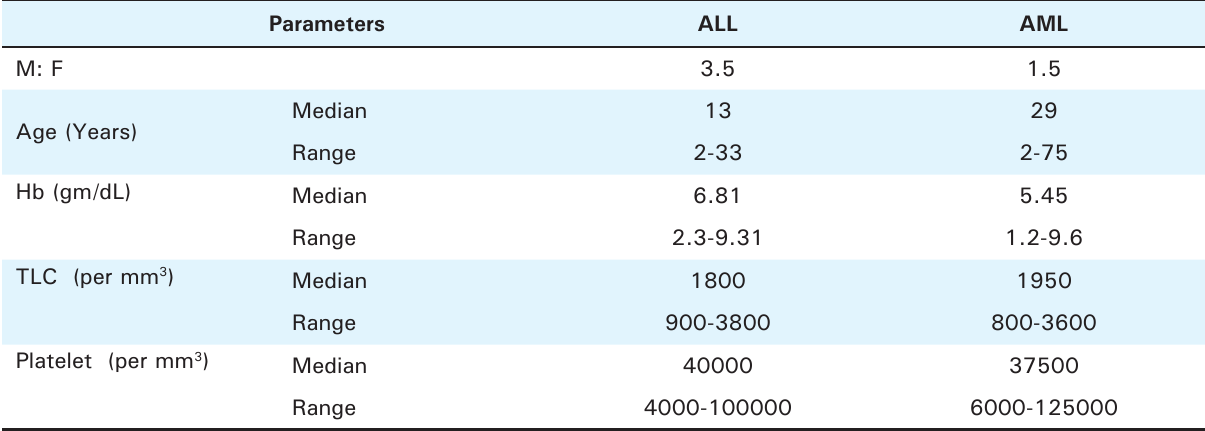
Table 3. Patient pro fi le and hematological parameters of ALL and AML in cases of pancytopenia Parameters